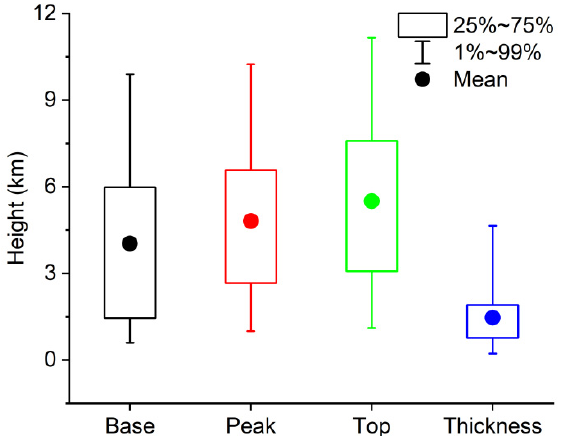
Figure 5. Box plots of cloud base height (black), cloud peak height (red), cloud top height (green) and cloud thickness (blue) during the observation period.